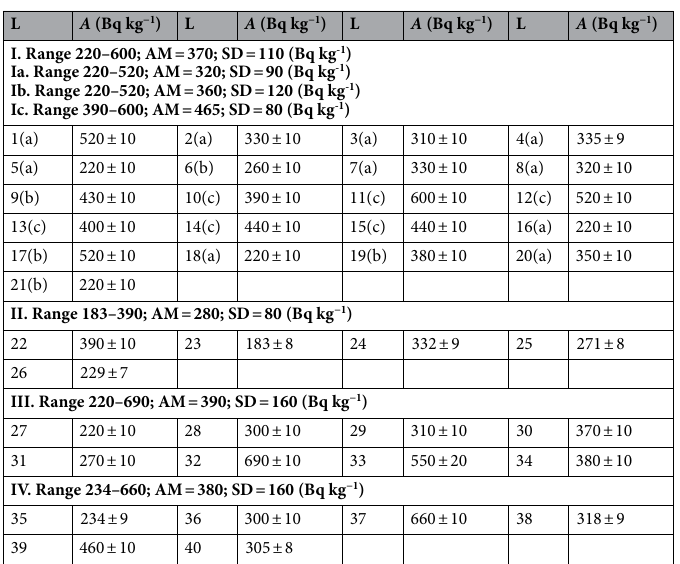
Table 2. Activity concentrations of 210 Pb in mosses sampled at locations L = 1–40 that are shown in Fig. 1. Results are presented in Bq per kg of dry mass, with uncertainties expressed using the coverage factor two. For area I, letters in brackets next to location numbers indicate the type (Ia, Ib, Ic) of terrain. Ranges of measured values, AM, and SD are listed for sampling areas I-IV and also for terrain types Ia, Ib, and Ic. If all samples are treated as a single dataset, the range of values is 183–690 Bq kg −1 , whereas AM = 360 Bq kg −1 and SD = 125 Bq kg −1